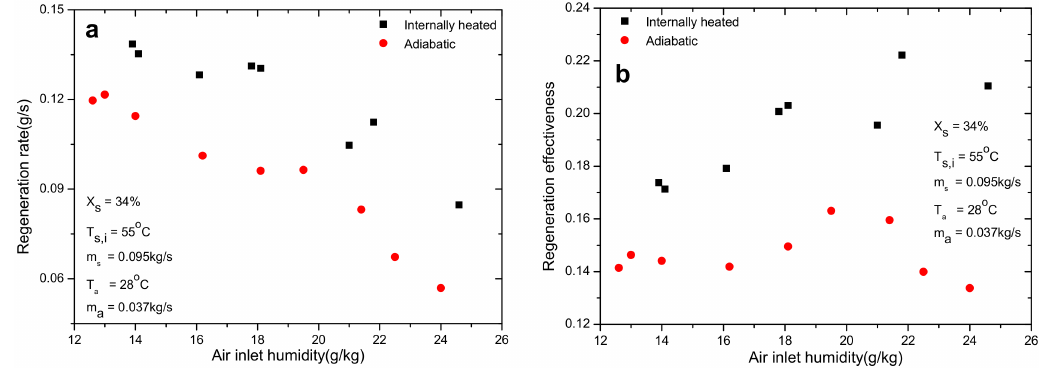
Figure 9. Effect of air inlet humidity on regeneration performance: ( a ) regeneration rate; ( b ) regeneration effectiveness.